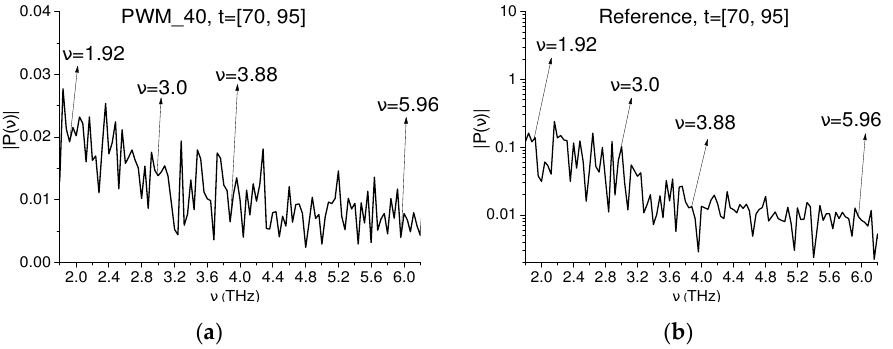
Figure 15. Fourier spectra of the PWM_40 s-sub-pulse in a linear scale ( a ) and reference spectrum in a logarithmic scale ( b ) in the time interval t = [70, 95] ps.